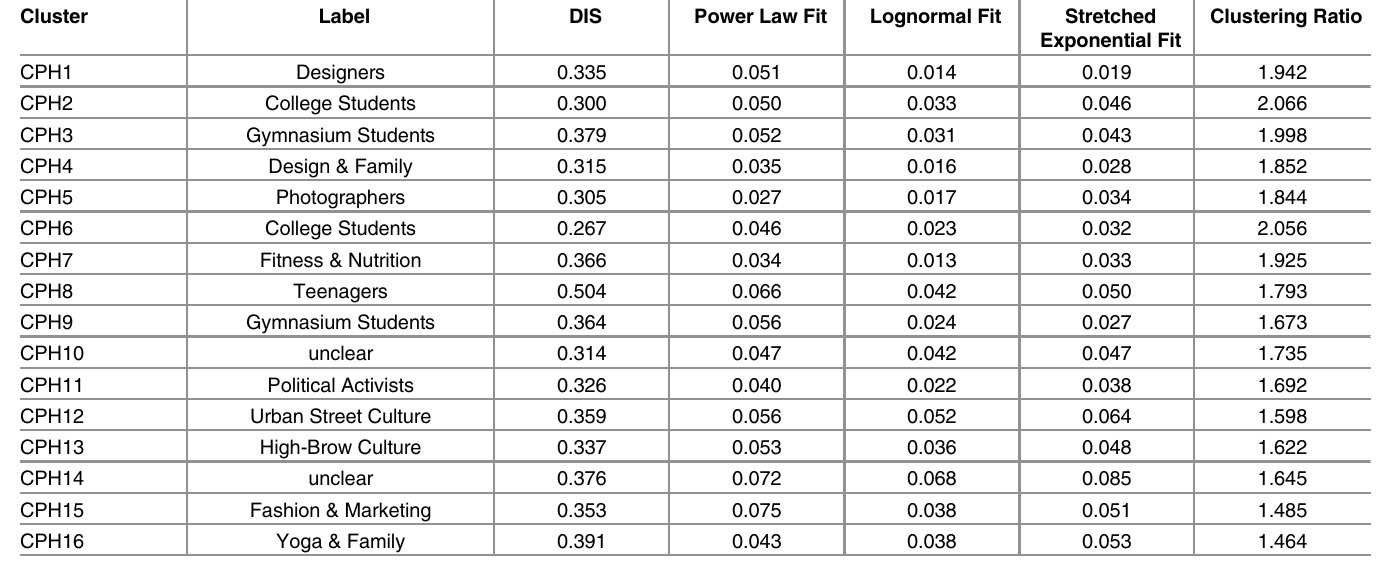
Table 5. Additional data on Copenhagen